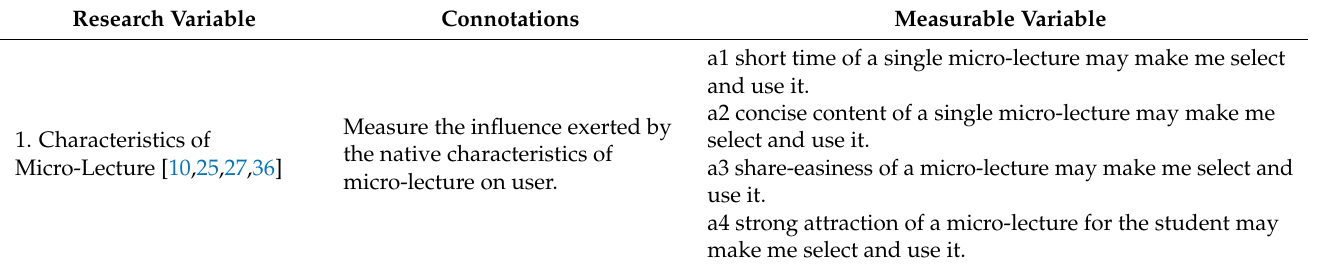
Table 3. Connotations and measurable variables of micro-lecture